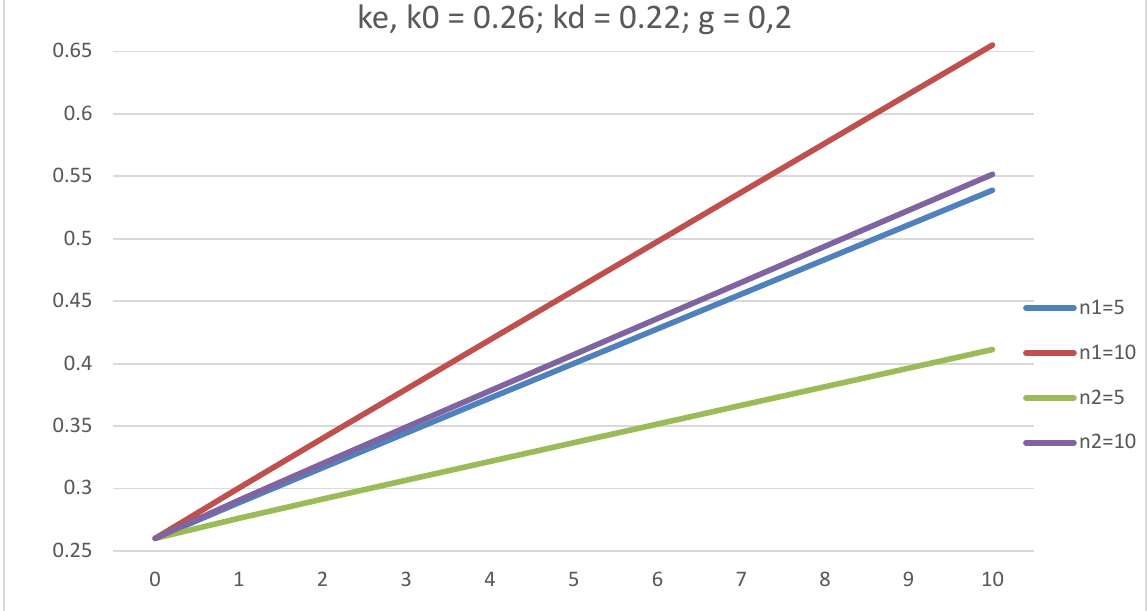
Figure 16. The dependence of equity cost, ke, on leverage level, L, in GBFO theory with payments of tax on profit at the end of periods (1) and advance payments (2) at k 0 = 0.26; k d = 0.22; t = 0.2; g = 0.2, for five-year and ten-year companies.